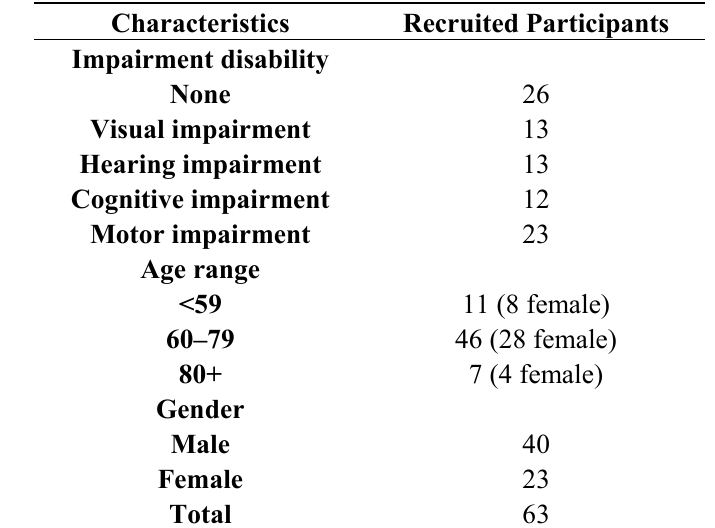
Table 2. Recruited participants’ characteristics. (Note that a person could have more than one